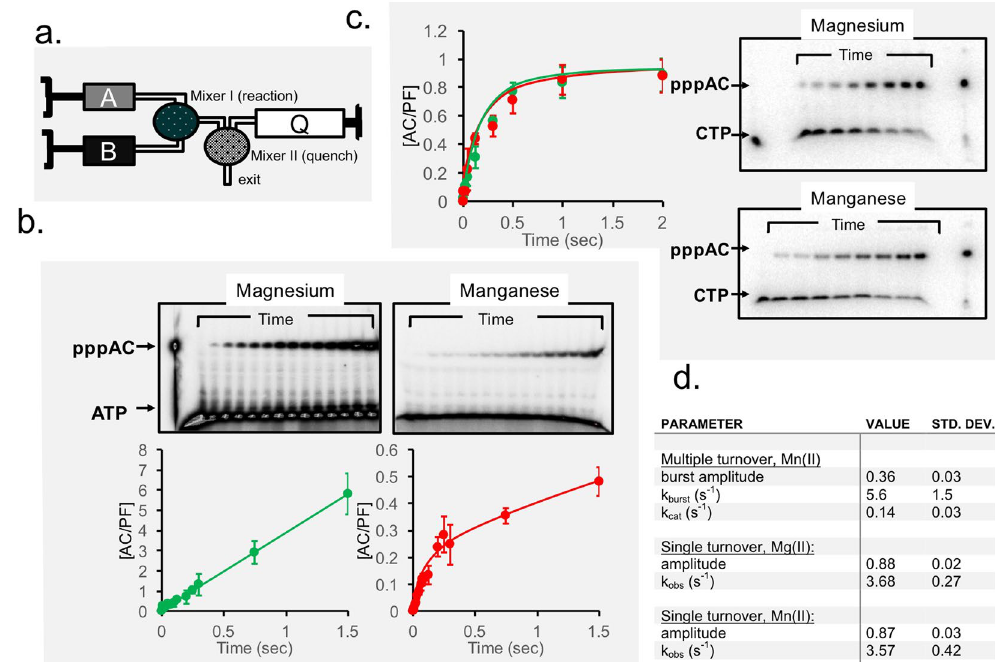
Figure 3. Dinucleotide synthesis by the T7 primase fragment catalyzed by Mn(II) or by Mg(II). ( a ) Experimental setup. ( b ) Single-turnover dinucleotide synthesis was initiated by mixing 25 µ M T7 primase and 100 µ M template (5 ′ -GTCA 10 -3 ′ ) with 5 mM MnCl 2 , 1 nM γ - 32 P ATP and 1 mM CTP in a rapid quench- flow instrument. Reactions were quenched after various incubation times, and products were separated by gel electrophoresis. The fraction of dinucleotide product formed as a function of time was plotted for Mg(II) (green curve) and Mn(II) (red curve), and the curves were fit to a single-exponential function. ( c ) Dinucleotide synthesis was initiated by mixing (final concentrations) 10 µ M T7 primase and 100 µ M template with 10 mM MgCl 2 or 2 mM MnCl 2 , 1 mM ATP and 1 mM CTP (spiked with [ α - 32 P CTP]) in a rapid quench- flow instrument. Reactions were quenched after various incubation times and products were separated by gel electrophoresis. The concentration of dinucleotide formed divided by the enzyme concentration is plotted versus time for MgCl 2 and MnCl 2 , and the curves were fit to either a linear or a burst equation. ( d ) Table listing the rate constants and the corresponding uncertainties that were used to fit the